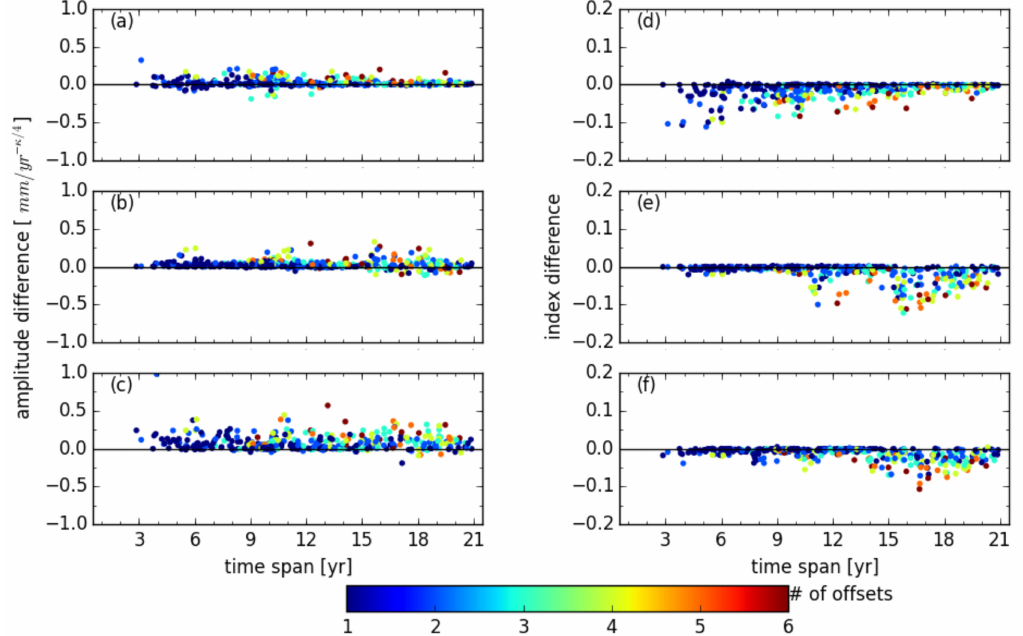
Figure 6. Noise difference between the solution sim_unit_none and sim_unit_real for amplitudes ( left panel ) and spectral indexes ( right panel ) of the power-law noise, with ( a , d ) for the east, ( b , e ) for the north, and ( c , f ) for the vertical component. The number of offsets in the postion time series is shown with different